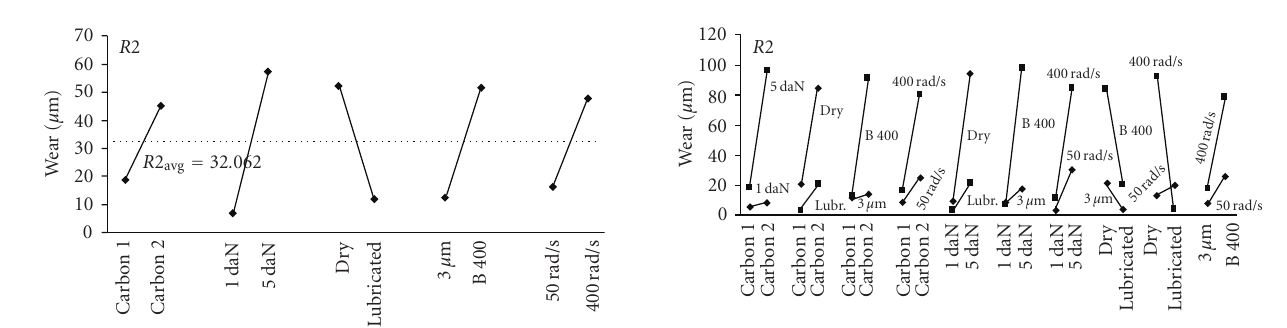
Figure 6: Main e ff ects on the wear ( R 2).